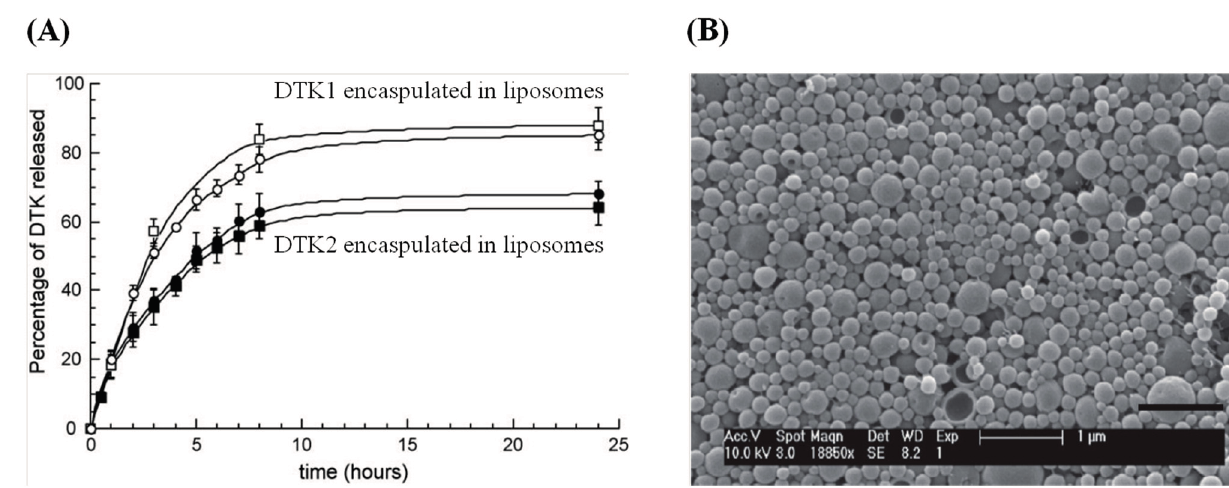
Figure 11. ( A ) Release profile of DTK1 and DTK2 encapsulated in liposomes; ( B ) SEM image of PLGA-siRNA particles and in vitro nectin mRNA knockdown comparing si-nectin lipoplex (reprint with permission from Ref.